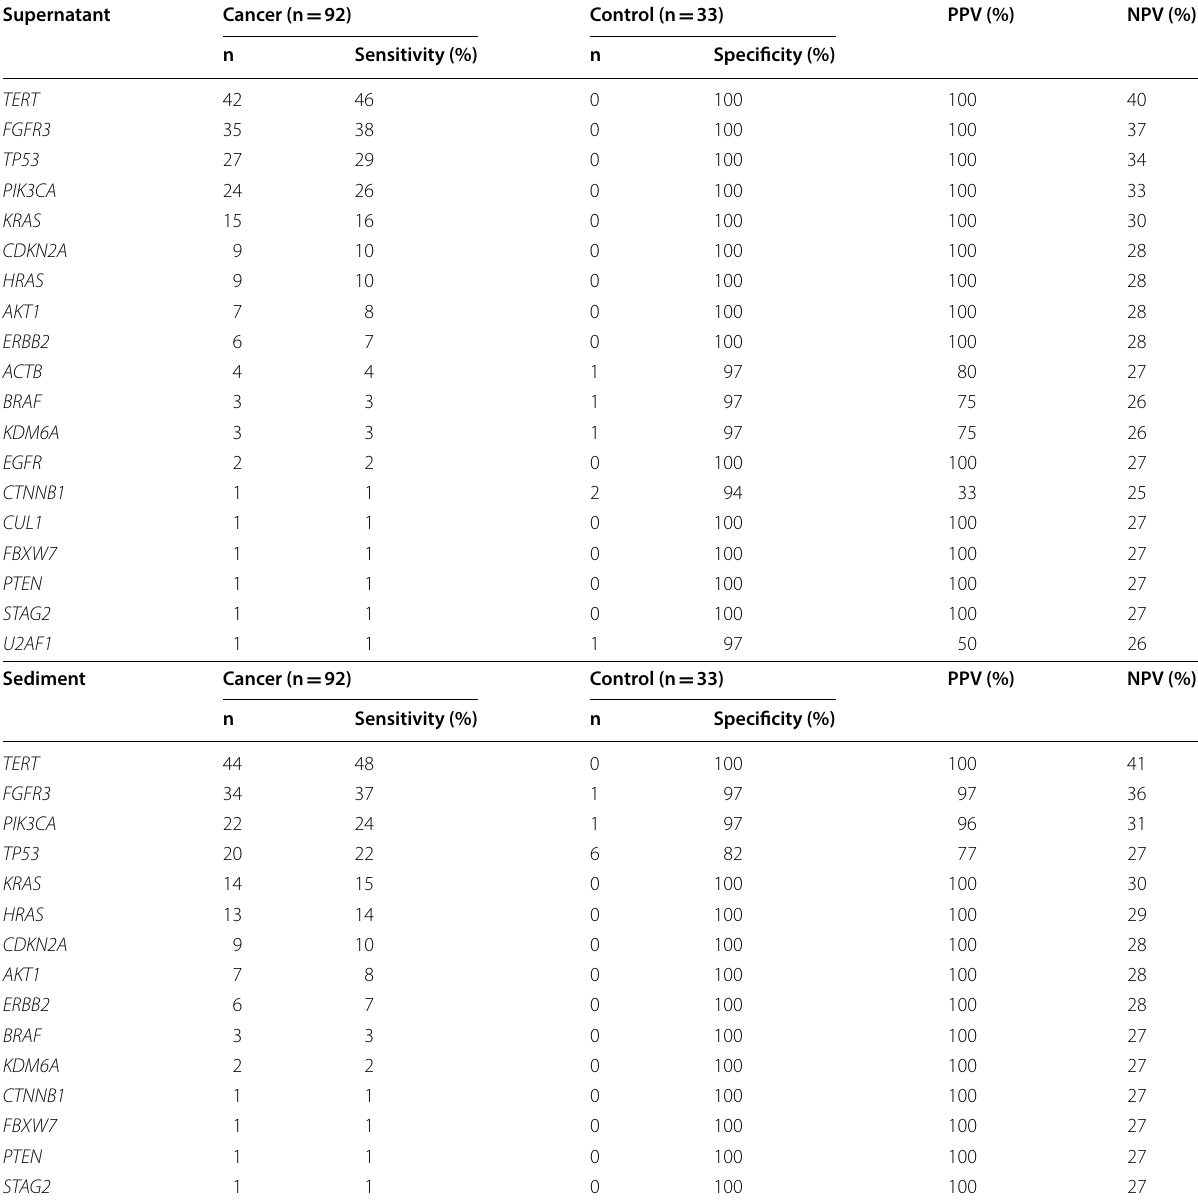
Table 4 Gene mutation detection in urine supernatant and urine sediments